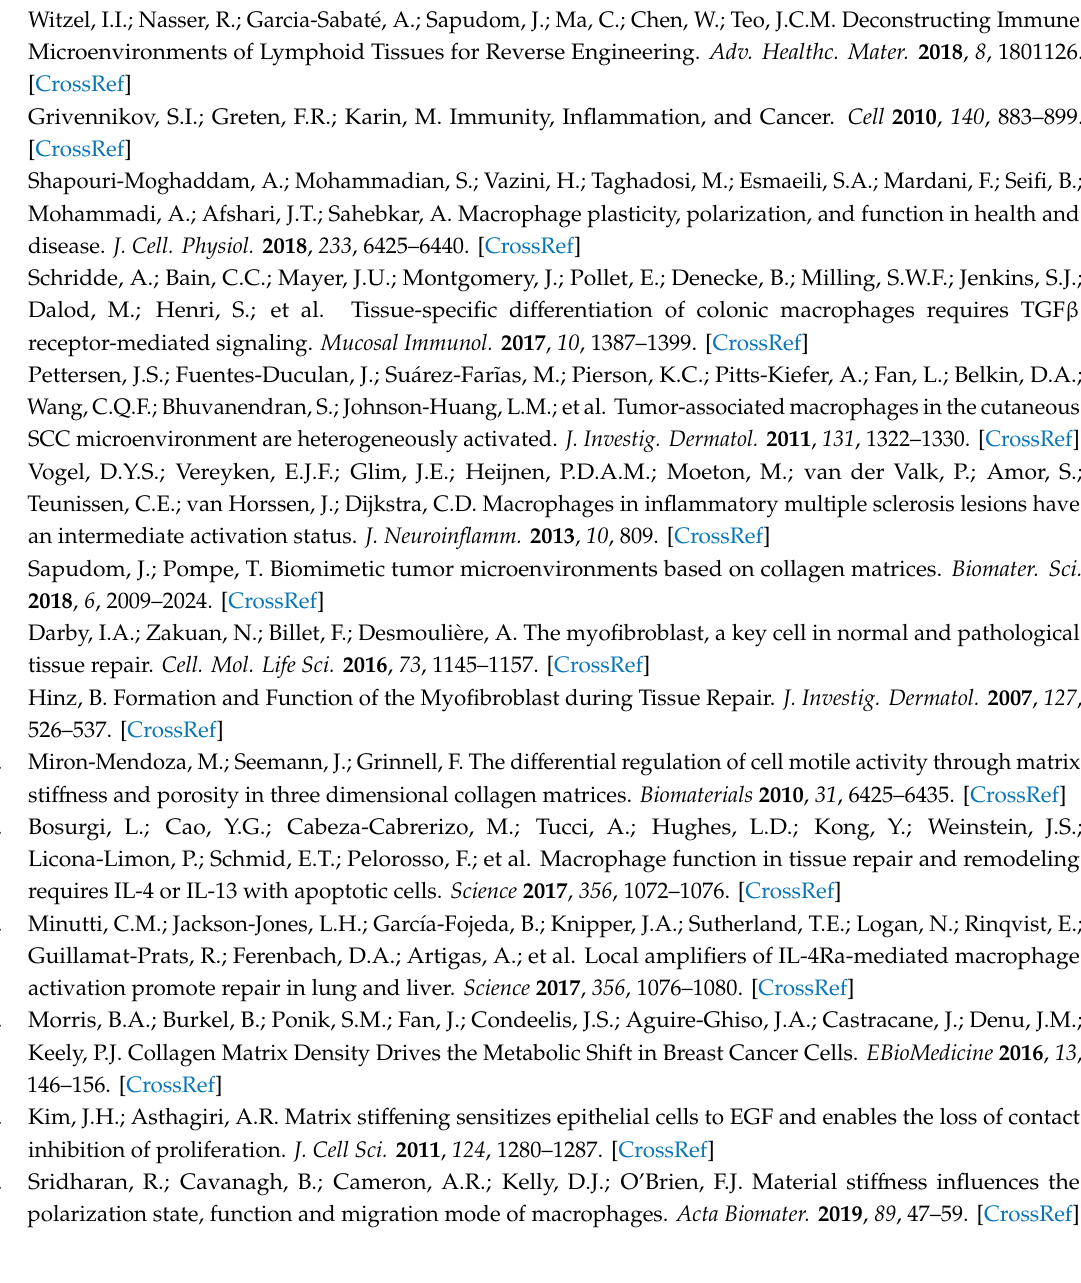
collagen matrices of concentration of 1, 2 and 3 mg / mL after 3 using ELISA. Figure S2: Flow cytometry analysis of unstained macrophages. Figure S3: Quantitative analysis of free active TGF- β 1 secretion by macrophages in a co-culture with fibroblasts after 3 days of culture using ELISA. Figure S4 Quantitative analysis of aSMA expression by macrophages after 3 days of culture using qPCR. Table S1: Primer